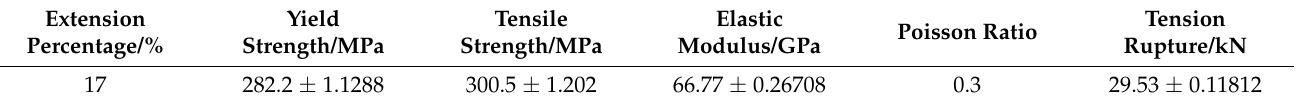
Table 3. Tensile mechanical properties of Al6005A-T6 aluminum alloy profiles.